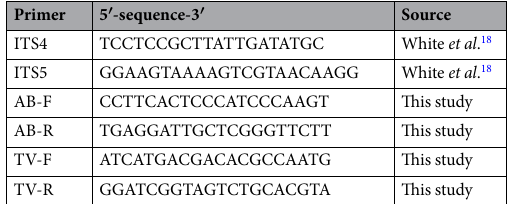
Table 1. Primers used to assess the adequacy of nucleic acid samples from dried mushrooms as templates for PCR